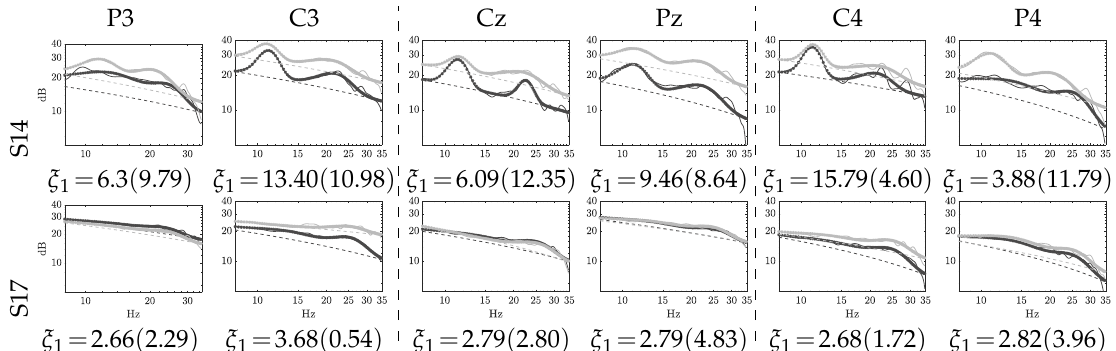
Figure 4. Examples of pre-training power spectral density (PSD)-fitting computed within resting data: baseline inverval (black line) and resting (gray line). Values of ξ 1 are reported for the sensorimotor area of baseline inverval and (resting) states.